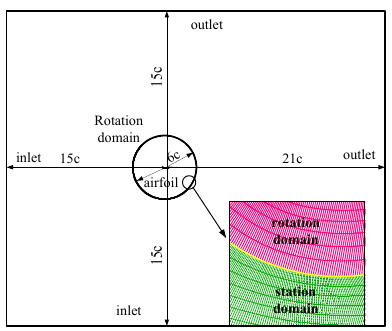
Figure 1. Airfoil boundary layer mesh.